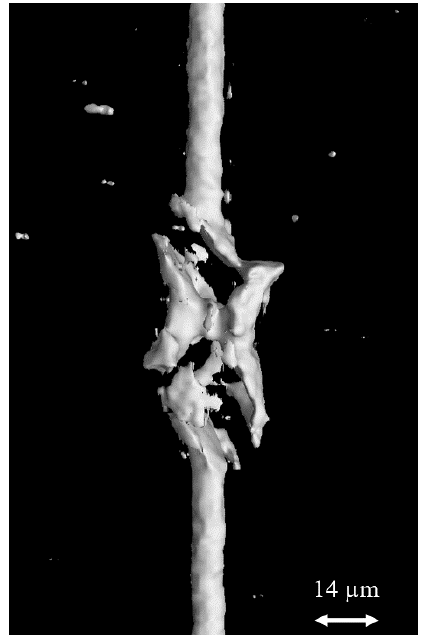
Figure 5. Example of one 3D location of fiber fracture image in high-resolution, taken by XRM, allowing the measurement of the inclination angle of the fracture planes and the size of the small fracture pieces between single fragments.